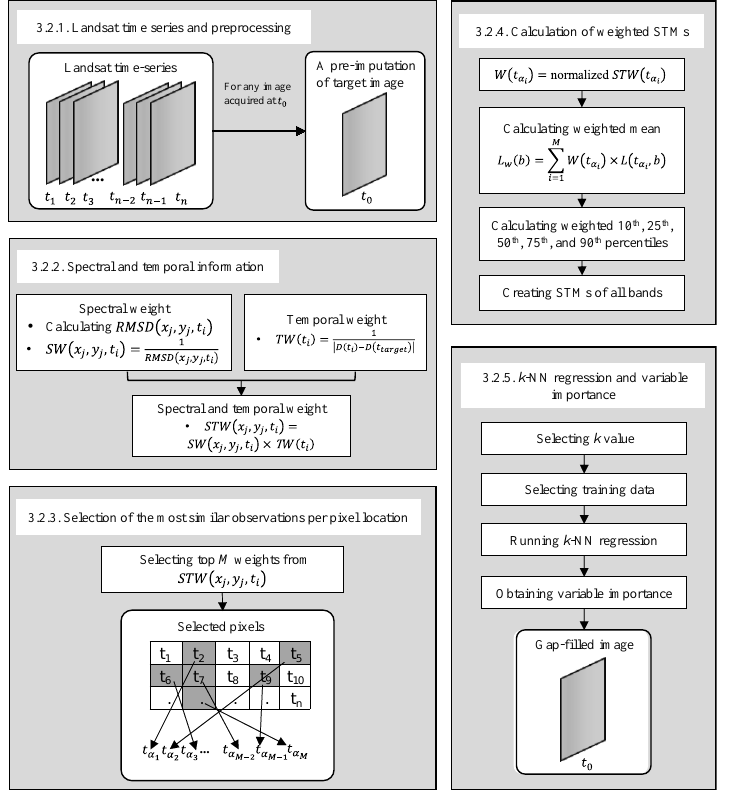
Figure 2. Workflow of the STIMDR method corresponding to the subtitles in Section